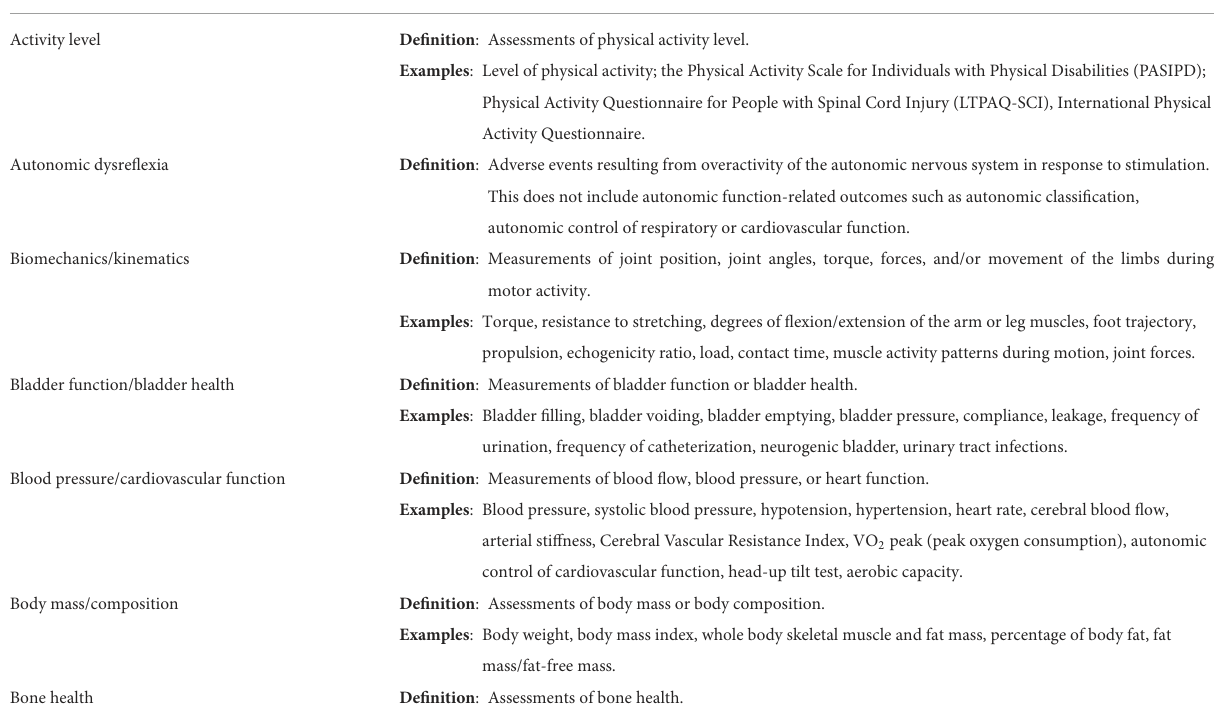
TABLE 2 Outcome measure